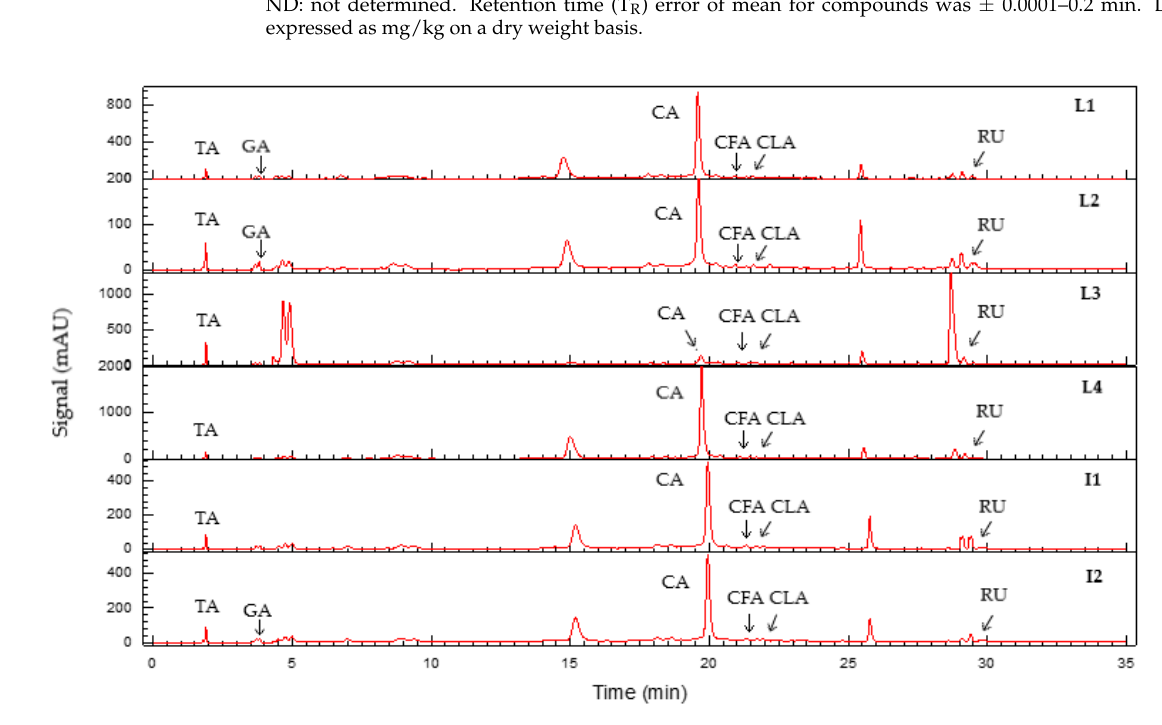
Figure 6. HPLC-DAD chromatograms of L1, L2, L3, L4, I1, I2 PR extracts. TA—tannic acid; GA—